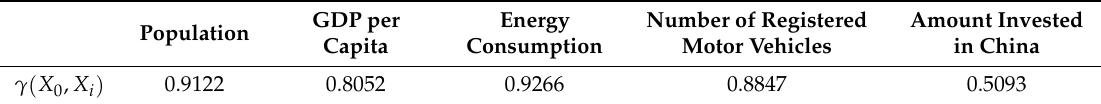
Table 10. Grey correlation for the amount of CO 2 emissions and